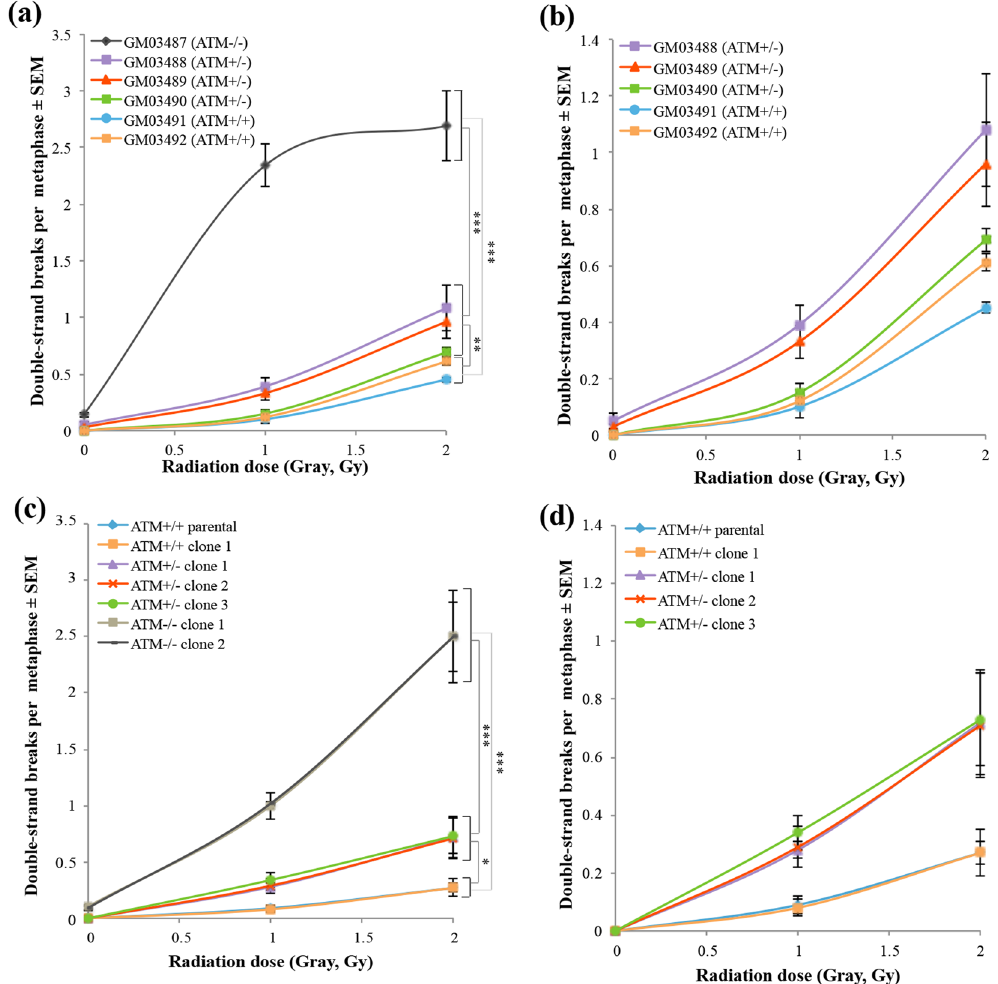
Figure 3. PNA-FISH analysis confirmed the effect of ATM heterozygous mutations on the cellular radiosensitivity in a different or uniformed genetic background. ( a ) Averaged unrepaired DSBs per metaphase in fibroblasts from all members of the A-T-affected family (mean ± SE; t-test; *** p < 0.001, ** p < 0.01, * p < 0.05; values of p > 0.05 were not significant; n = 3; > 100 metaphase cells per experiment). ( b ) The graph from (a) with magnification of the Y-axis including the percentage of averaged unrepaired DSBs per metaphase in fibroblasts from the A-T heterozygous carriers and normal individuals in the A-T-affected family. ( c ) Average unrepaired DSBs per metaphase in ATM -edited hTERT-RPE1 cell lines (mean ± SE; t-test; *** p < 0.001, ** p < 0.01, * p < 0.05, values of p > 0.05 were not significant; n = 3; > 100 metaphase cells per experiment). ( d ) The graph from (a) with magnification of the Y-axis including the percentage of averaged unrepaired DSBs per metaphase in ATM + / − and ATM + / + cell